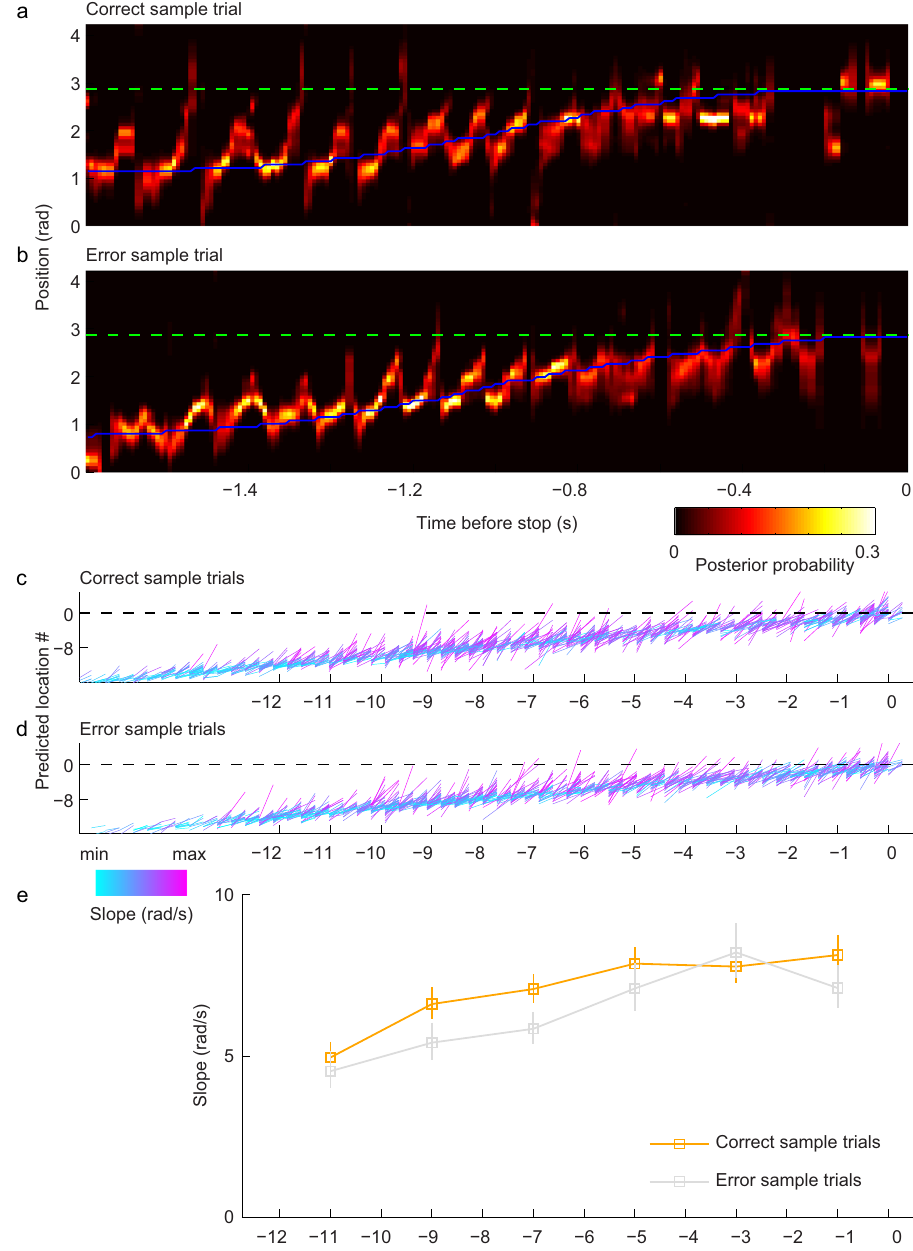
Fig. 4 Place cell sequences exhibited steeper slopes in correct sample trials than in error sample trials. a – e Same as ( a – e ) in Fig. 3 but for sample trials. Note that correct and error trials were de fi ned by rats ’ responses in subsequent test trials (main effect of trial type: F(1,2838) = 15.9, p = 6.9 × 10 − 5 , n = 1818 positive sequences detected from correct sample trials and n = 1032 positive sequences detected from error sample trials). Data are presented as mean ± error bars (95% bootstrapped con fi dence intervals) in ( e correct vs. error) for cells that fi red early in the sequence: χ 2 (2) = 7.8, p = 0.02). These results suggest that place cells that start a sequence begin fi ring at a signi fi cantly earlier theta phase during correct trials than during error trials. In contrast, error trials in the spatial delayed match-to-sample task were not associated with abnormal temporal coordination of spikes by slow or fast gamma rhythms (Supplementary Figs. 5 and 6).